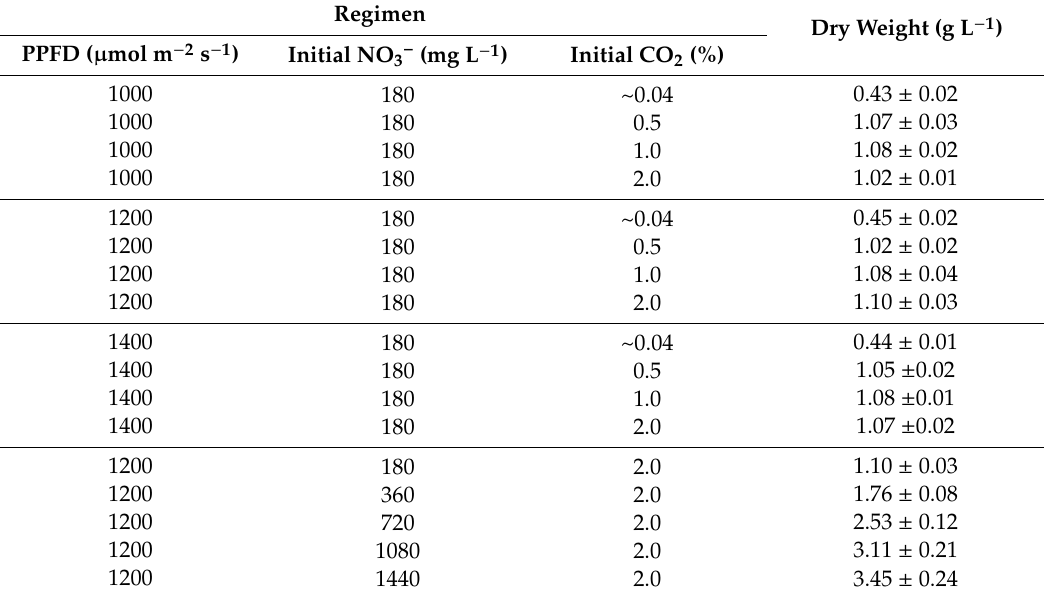
Table 2. The average dry weight levels of algal biomass at the end of the